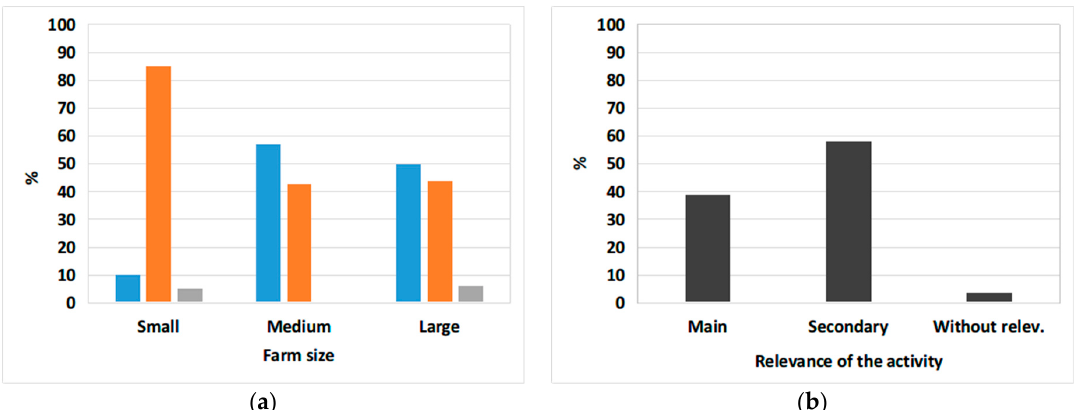
Figure 3. Relative frequency (%) of educational level of respondents by: ( a ) the farm size (Until the 4th grade, ; 5–9th grade, ; 10–12th grade, ; Higher education, ), and ( b ) the overall responses. Farm size: Small (lower than 25 m 2 ), Medium, Large (over 8.5 ha).